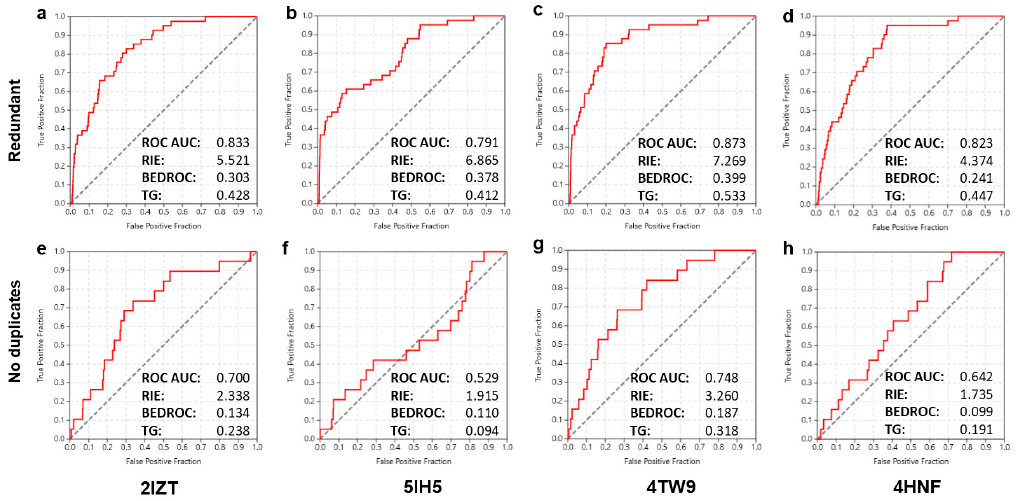
Figure 3. The ROC curves and key enrichment metrics obtained for the final combined screening effort of the NCI Diversity Set-II against CK1. Results obtained for the 3 high-performance (2IZT, 5IH5 and 4HNF) and 1 low-performance (4TW9) templates along with their corresponding pdb codes are shown (inlets a – h ). In the first ( a – d ) and second ( e – h ) lines, data for screens following the two distinct approaches with respect to redundancy are